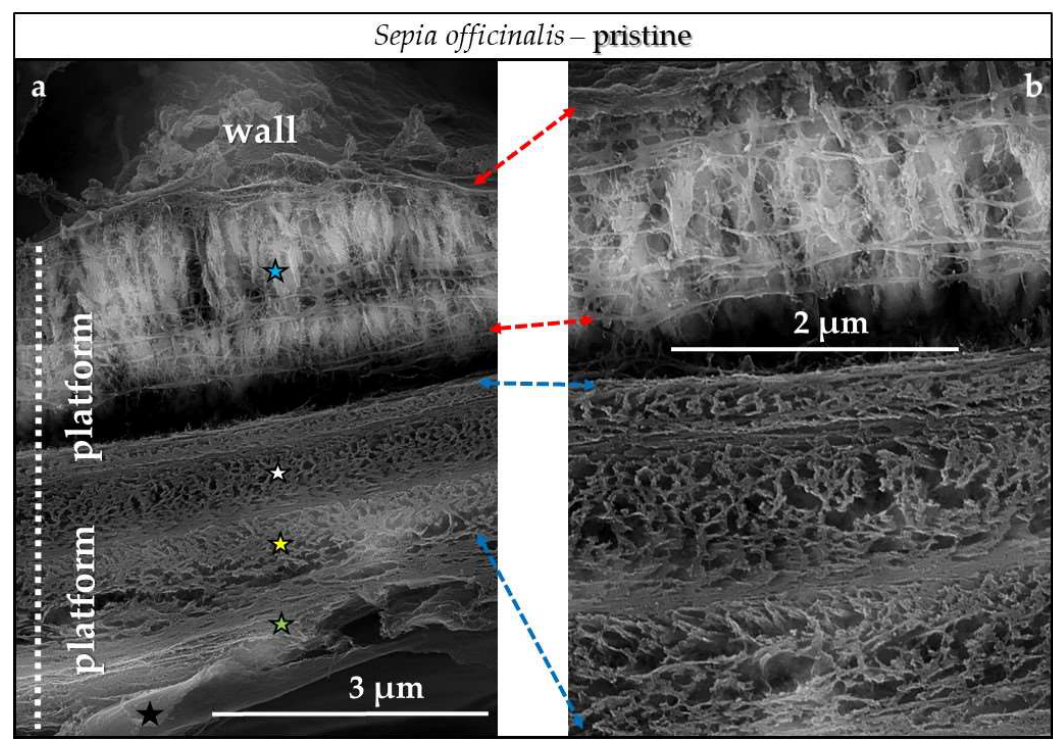
Figure A15. FE-SEM images of demineralized Sepia officinalis cuttlebone showing the organic component within the skeleton that encases aragonite crystallites and individual mineral units, e.g., aragonite rods, stacks of rods. The differently colored stars in ( a ) point to the different layers of a platform; see also Figure A11d. The black star in ( a ) indicates the presence of the thick biopolymer membrane that lines all outer surfaces of all structural elements within the cuttlebone; ( b ) Organic content within a platform shown with a slightly higher magnification, relative to that given in ( a ).